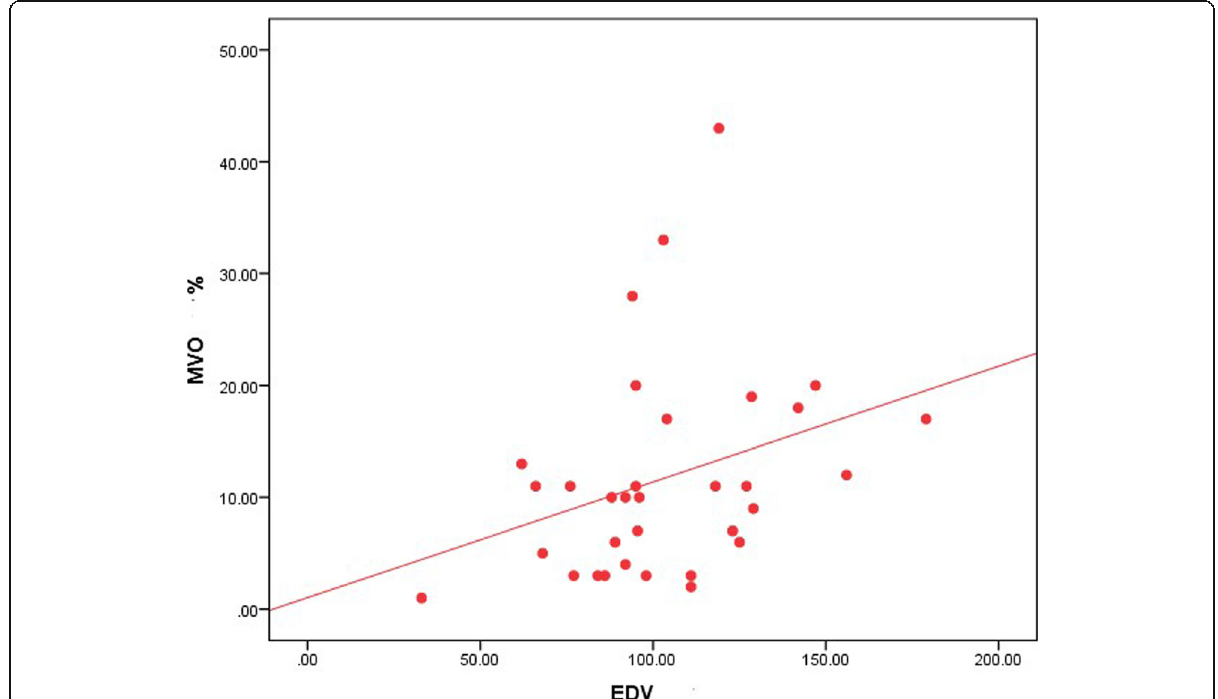
Fig. 4 A scatter plot matrix showing a significant positive correlation between MVO size % and LV EDVI measured at the 2nd visit (follow-up)